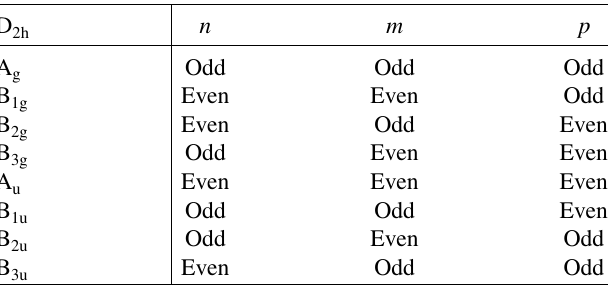
TABLE V. Classification of the eigenmodes in a rectangular cavity. Each eigenmode is specified by a set of integers ( n , m , p ). The corresponding irreducible representation is determined whether these integers are even or odd.